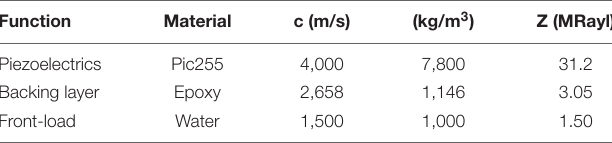
TABLE 1 | Materials used in simulation.